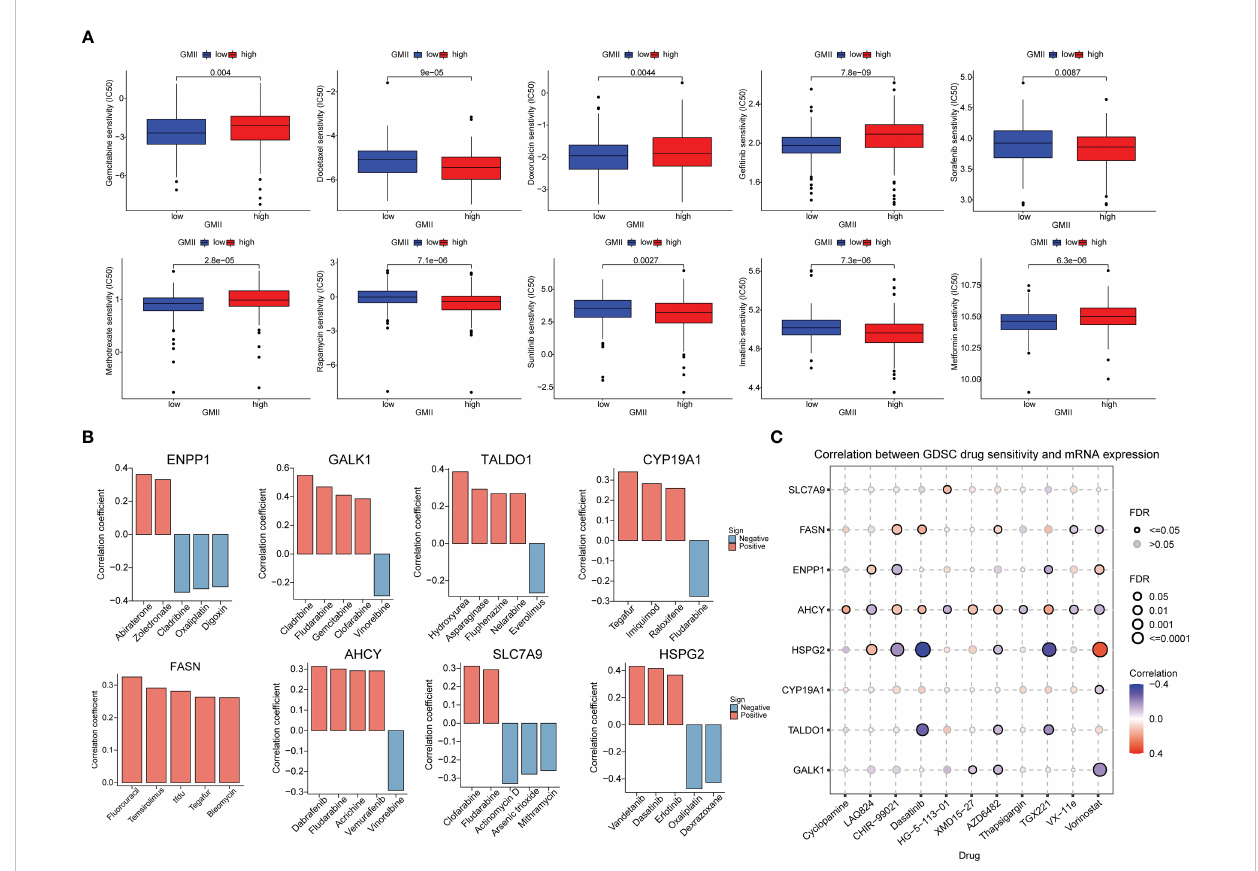
FIGURE 7 Effect of GMII on drug sensitivity. (A) Differences in response to commonly used chemotherapy drugs between high-GMII and low-GMII groups. (B) Construct the correlation between GMII gene and drug sensitivity. (C) Correlation between GDSC drug sensitivity and mRNA expression levels of eight genes that construct